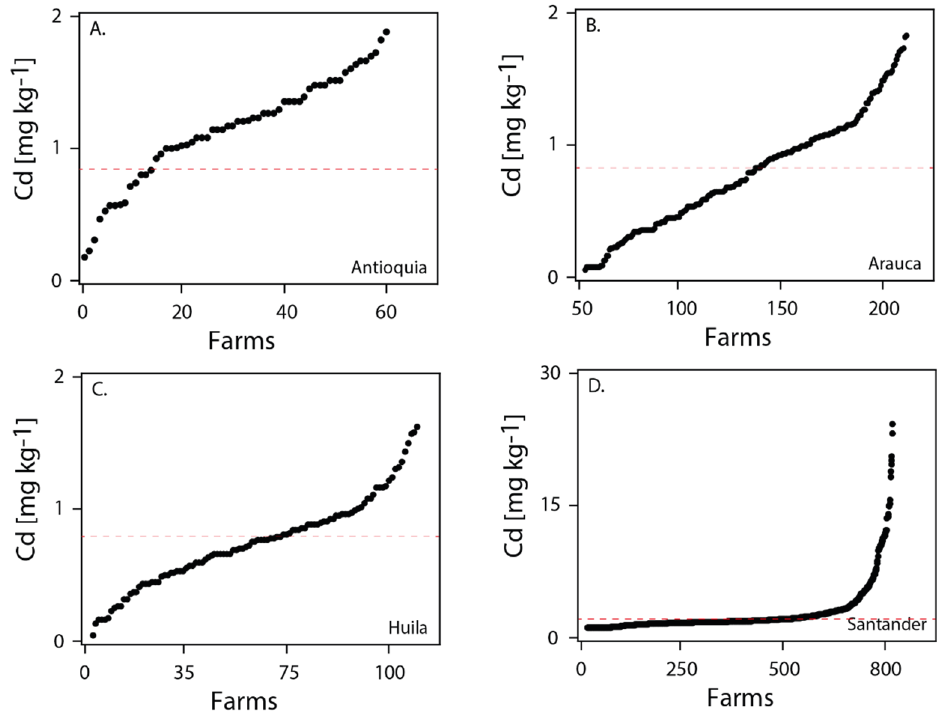
Figure 5. Distribution of cadmium (Cd) regarding four main cacao productive districts in Colombia. The districts correspond to ( A ) Antioquia, ( B ) Arauca, ( C ) Huila, and ( D ) Santander, showing the relative variability of Cd ranges found in each district.